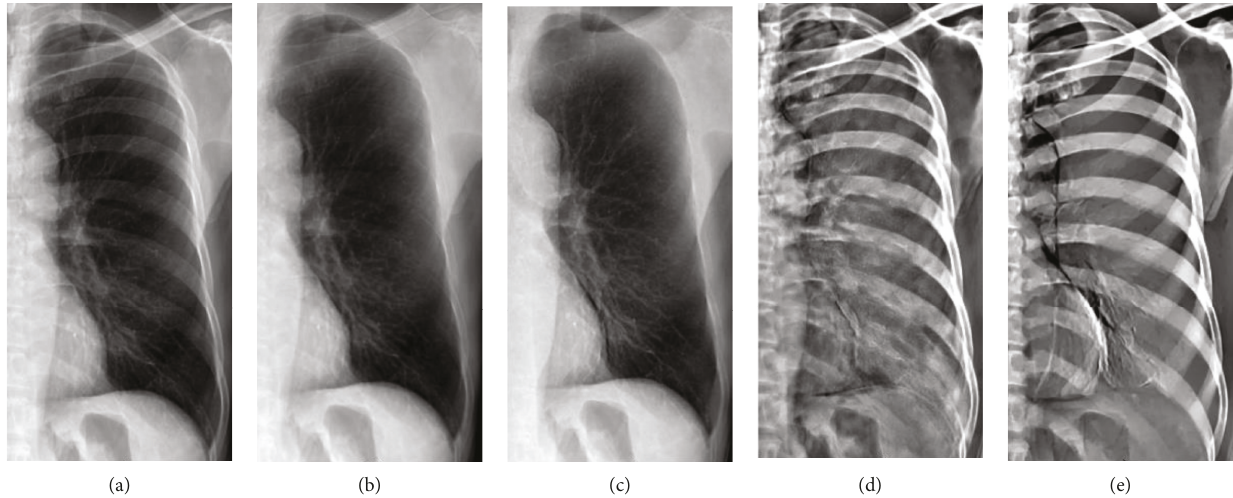
Figure 8: Decomposition results of a chest radiograph with motion artifacts: (a) the left lung fi eld of a chest radiograph; (b) the reconstructed soft tissue image by use of our method; (c) the actual DES soft tissue image; (d) the reconstructed bone image by use of our method; (e) the actual DES bone image with obvious motion